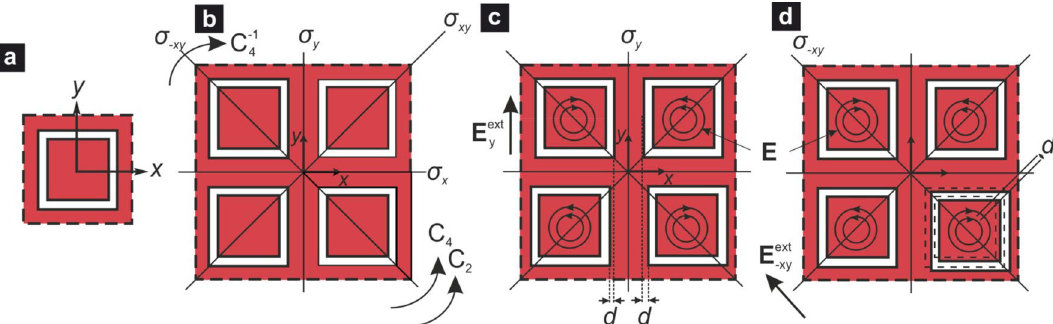
Figure 2. ( a ) Unit cell with C 4 v symmetry composed of a single SSR; ( b ) non-perturbed unit supercell, also with C 4 v symmetry, and its elements of geometrical symmetry; ( c ) perturbed unit supercell for AFMO mode y excitation, symmetry C s , d is the displacement of the unit cells along the x -direction; ( d ) perturbed unit − xy ′ is displacement of the unit cell along the diagonal supercell for AFMO mode excitation, symmetry C s , d direction (the dashed squares depict the nonperturbed unit cell). In ( c ) and ( d ) E ext y and E ext − xy are the electric fields of the linearly polarized incident wave and E is a simplified depiction of the in-plane electric field of resonant mode in the unit